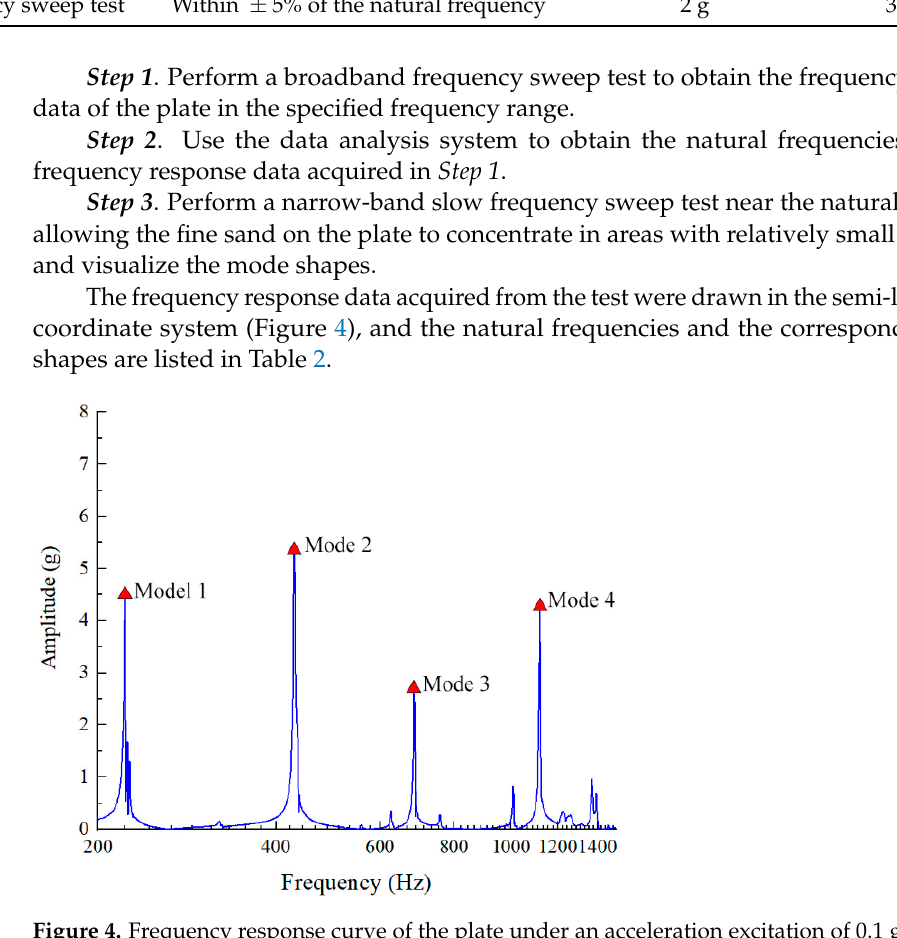
Figure 4. Frequency response curve of the plate under an acceleration excitation of 0.1 g.